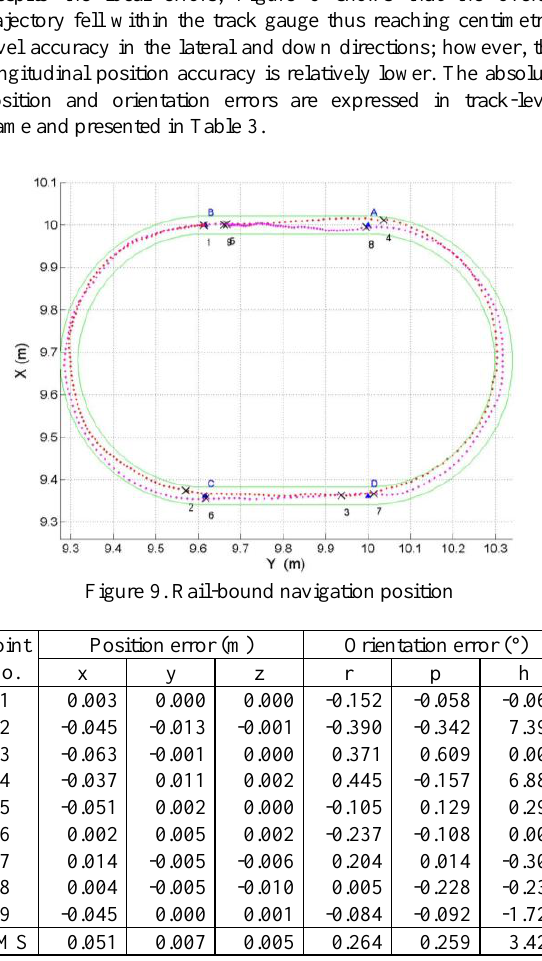
Table 3. Rail-bound navigation: position and orientation errors of check-points relative to the reference